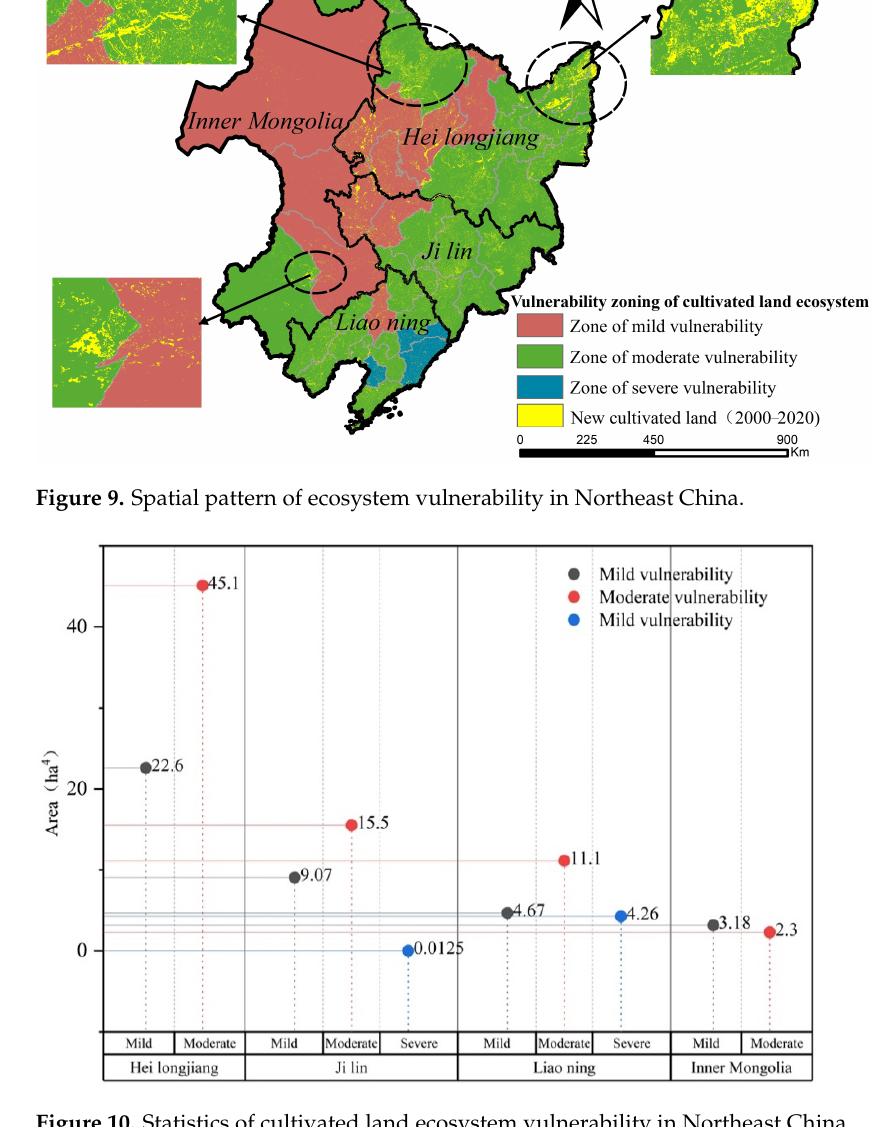
Figure 9. Spatial pa tt ern of ecosystem vulnerability in Northeast China.